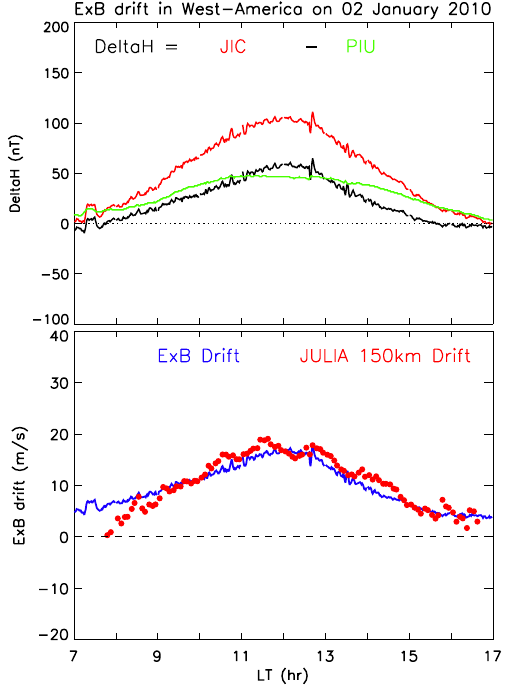
Fig. 2. (Top panels) the magnetic fluctuation recorded at the geo- magnetic equator (red curves) and off the magnetic equator (green curves) and the difference between red and green curve (black curve). (Bottom panels) an estimated E × B drift (blue curve) and red dots represent vertical drift velocity observed by the JULIA 150km radar,